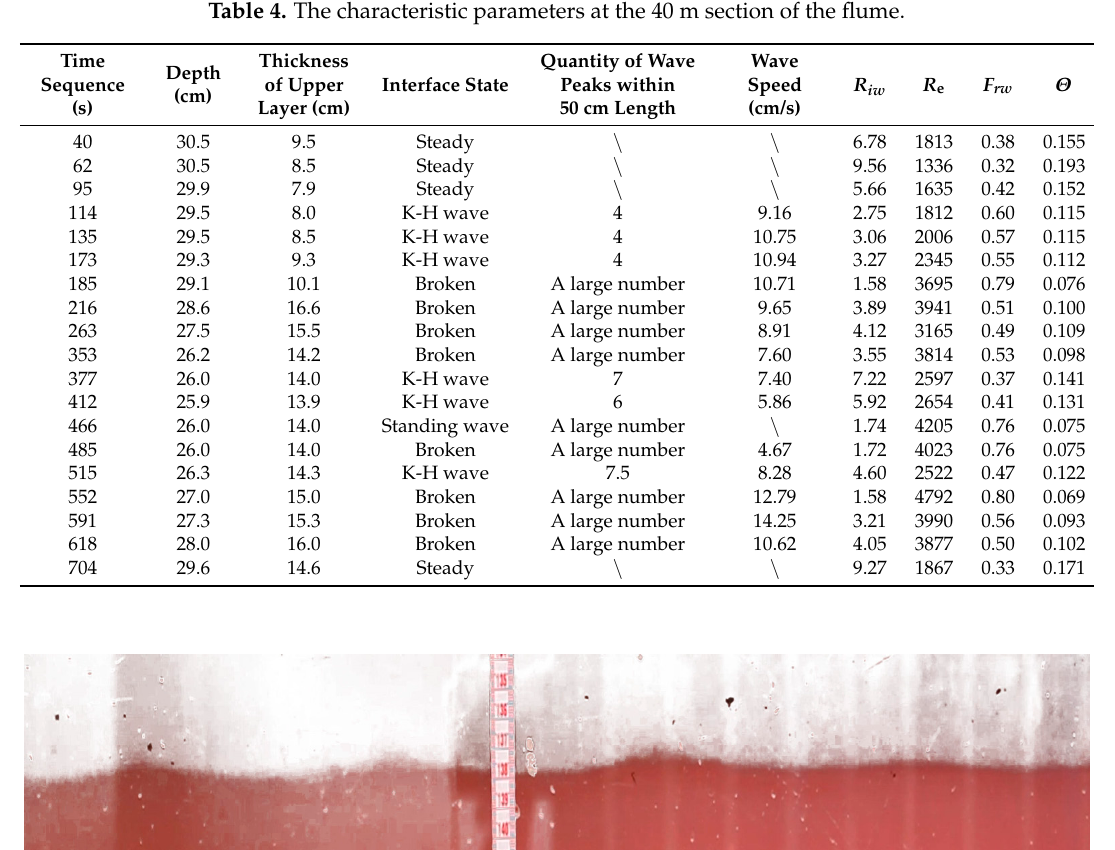
Table 4. The characteristic parameters at the 40m section of the flume.